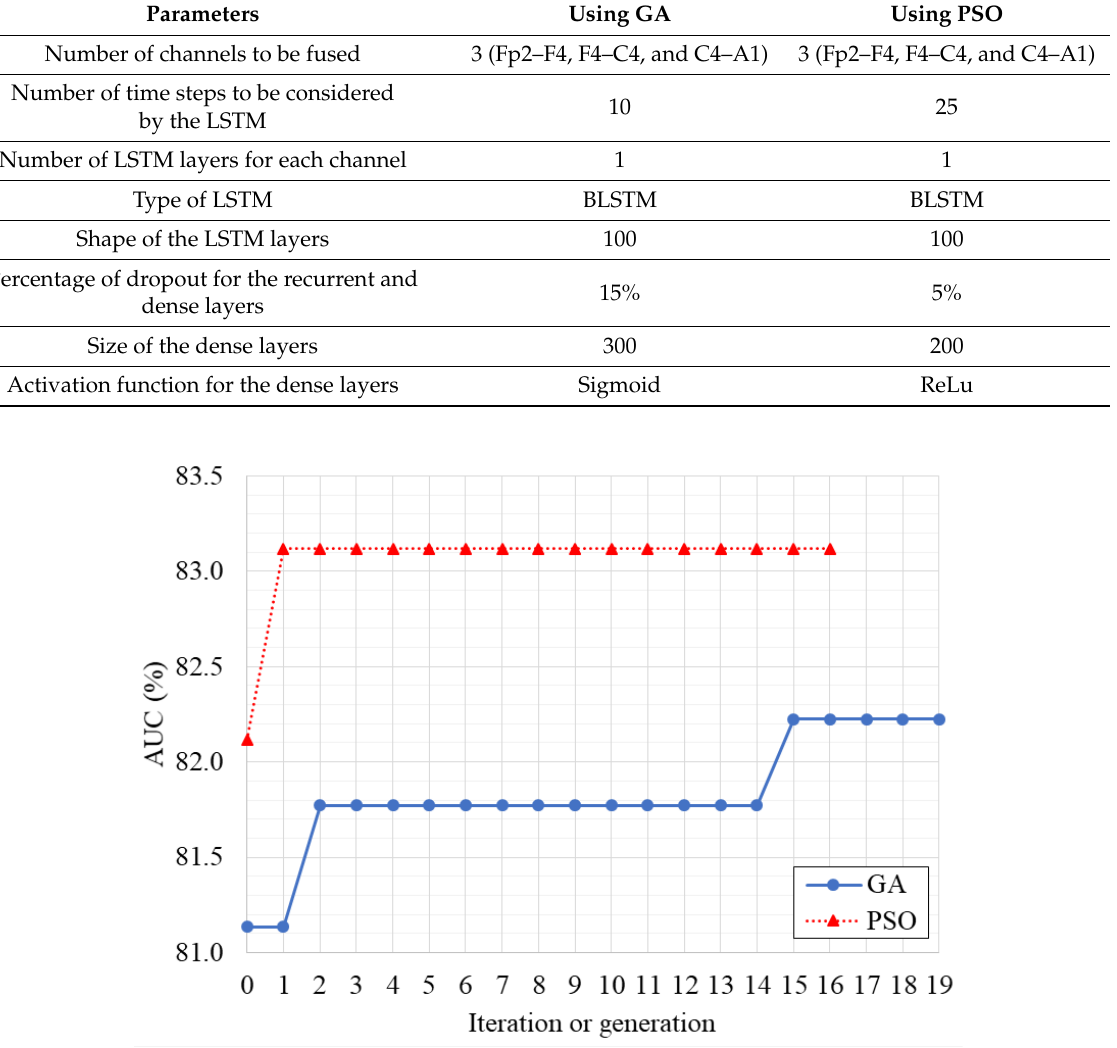
Figure 2. Variation of the AUC of the best solution found by the optimization algorithms.